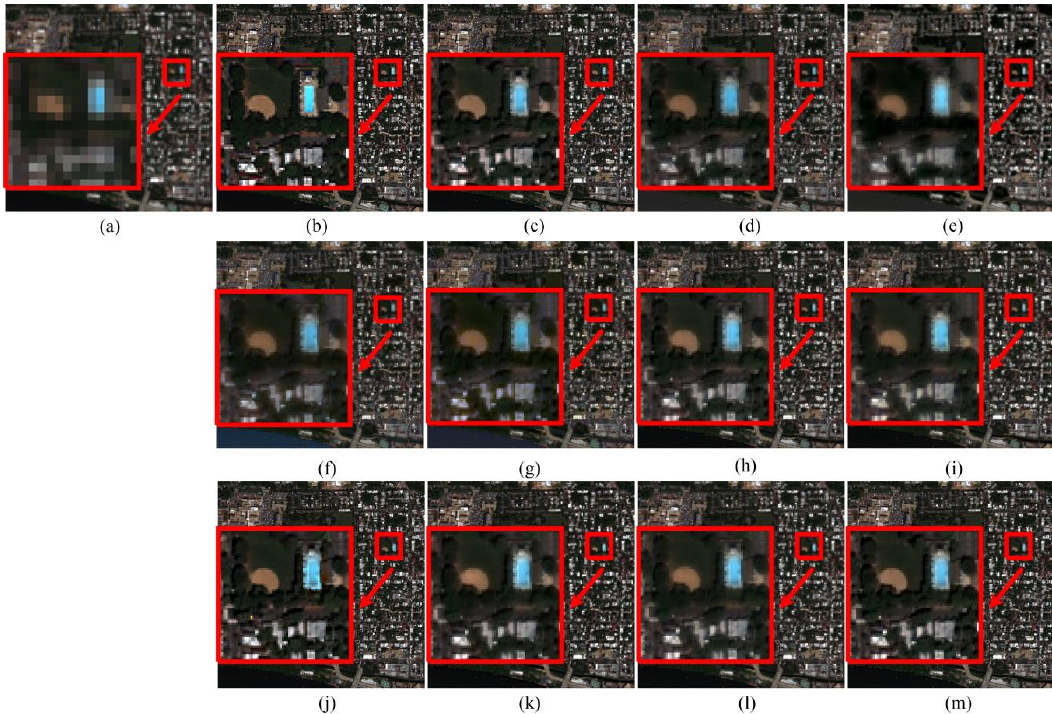
Figure 10. Pansharpening results of Washington dataset. ( a ) MS. ( b ) Ground-truth image. ( c ) PPCNN. Table 2. Comparison results for Washington dataset.